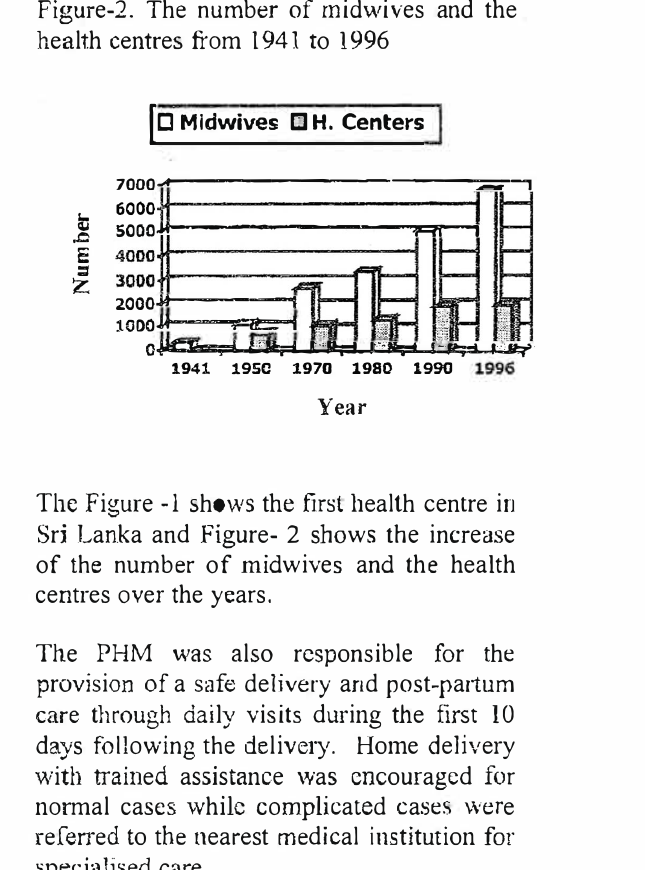
Figure-2. The number of midwives and the health centres from l 941 to